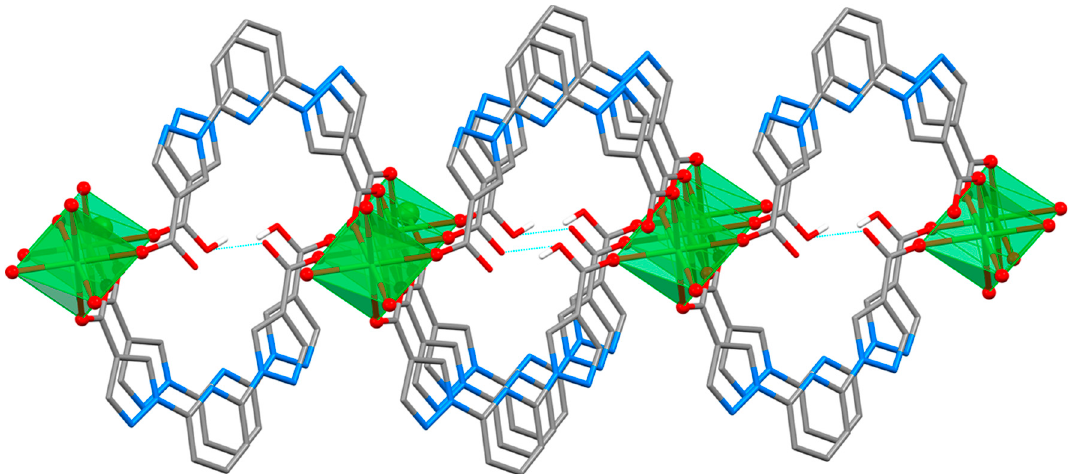
Figure 2. Lateral view of a layer of [Yb(L 4 )(HL 4 )] n in YbL 4 , with hydrogen bonds shown as dotted lines in cyan.